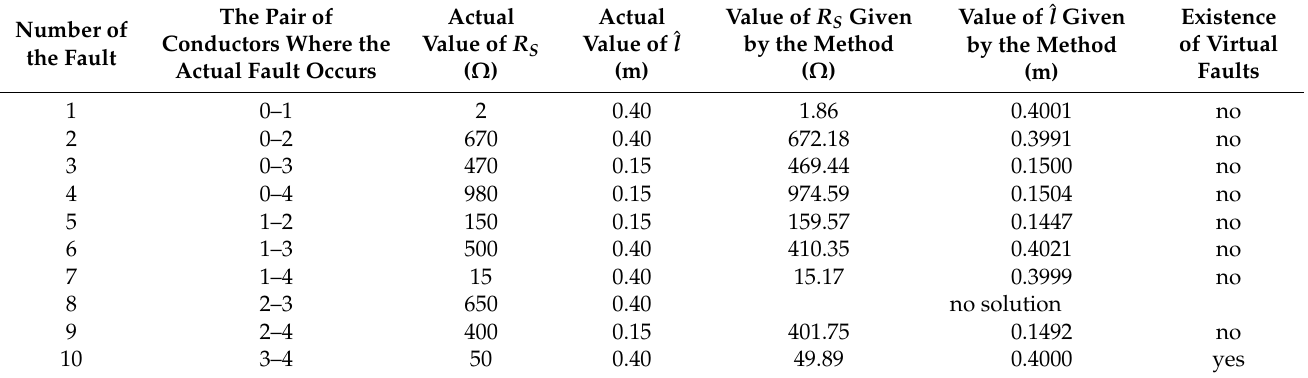
Table 2. Results of soft short diagnoses in the circuit of Figure 5.